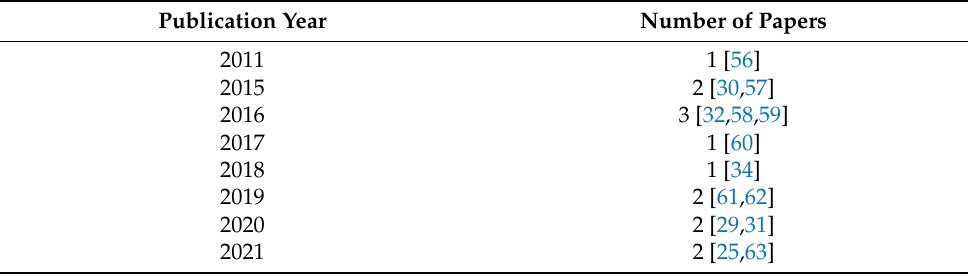
Table 2. The publication year of the final selected